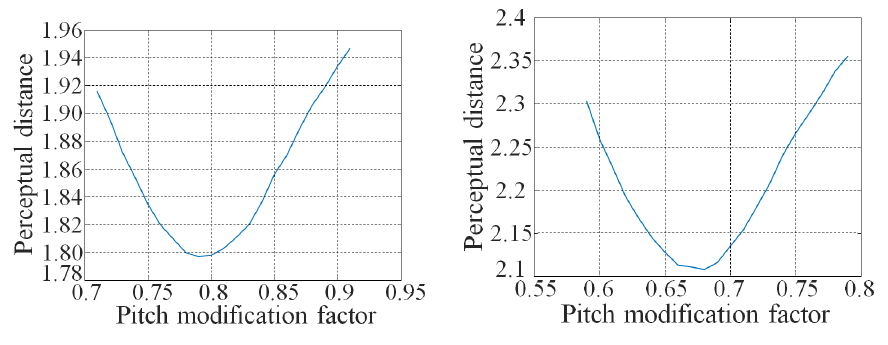
Figure 4. Examples of perceptual distances according to the pitch modification factors. Left : male-to-male. Right : male-to-female